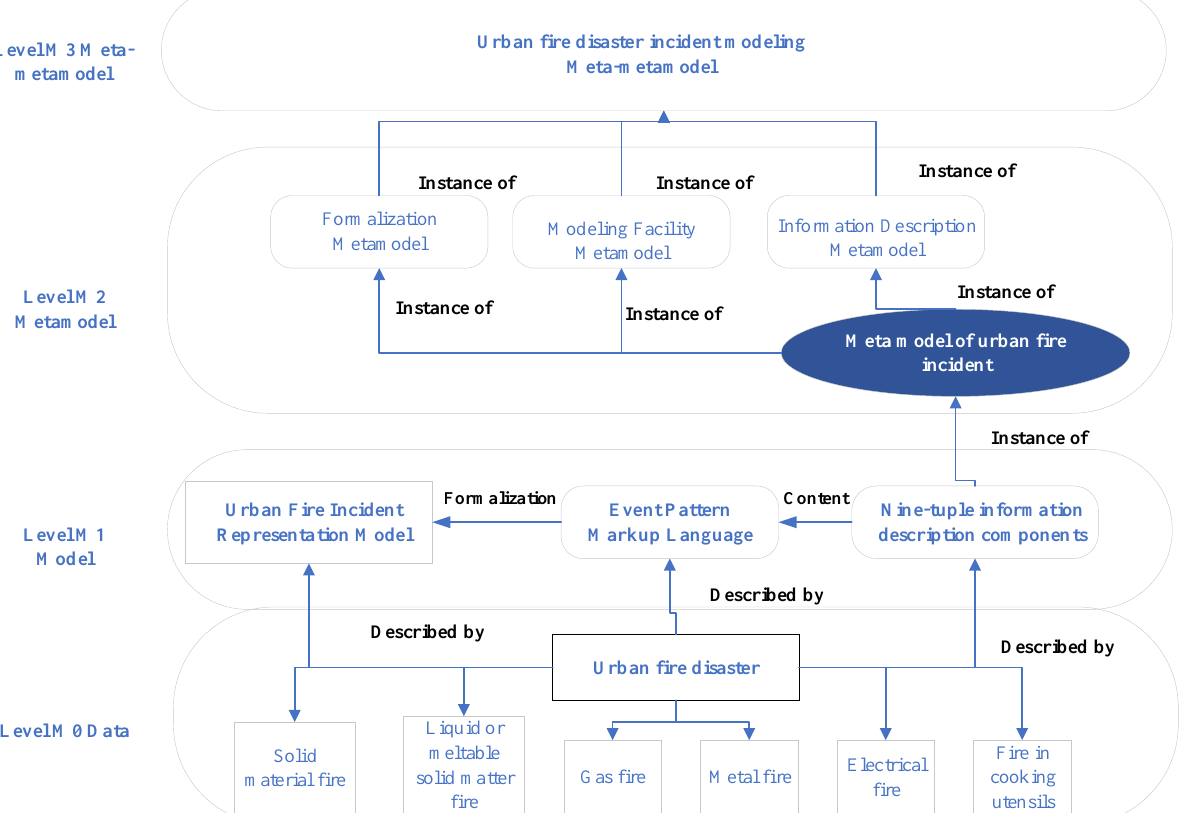
Figure 1. The urban fire incidents model based on the MOF